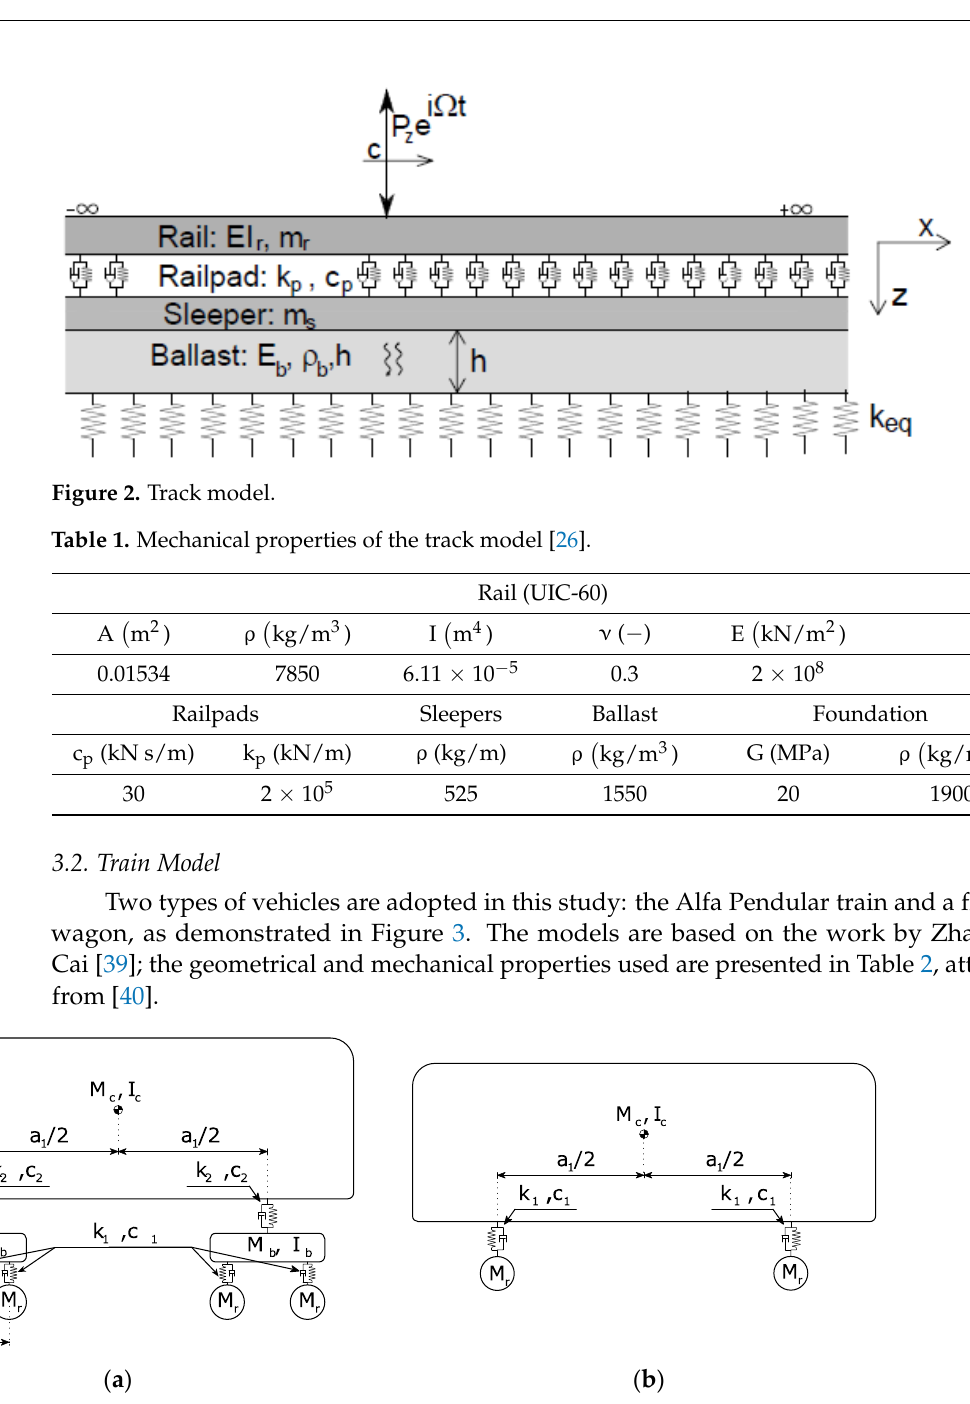
Figure 3. Dynamic models of the railway vehicle: ( a ) Alfa Pendular; ( b ) freight wagon. Table 2. Geometric and mechanical properties of the trains [40].